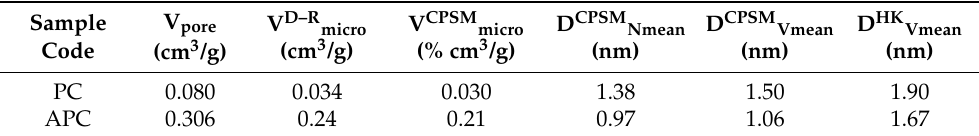
Table 1. Pore structure parameters derived from the CPSM model simulation of the overall N 2 adsorption–desorption hysteresis loop, the Dubinnin–Raduskevitch (D–R) method and the Horvath–Kawazoe (H–K) model.